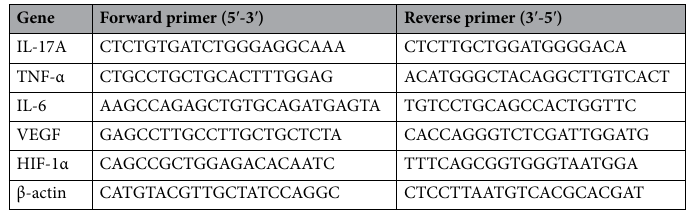
Table 1. List of the sequence of gene primers.